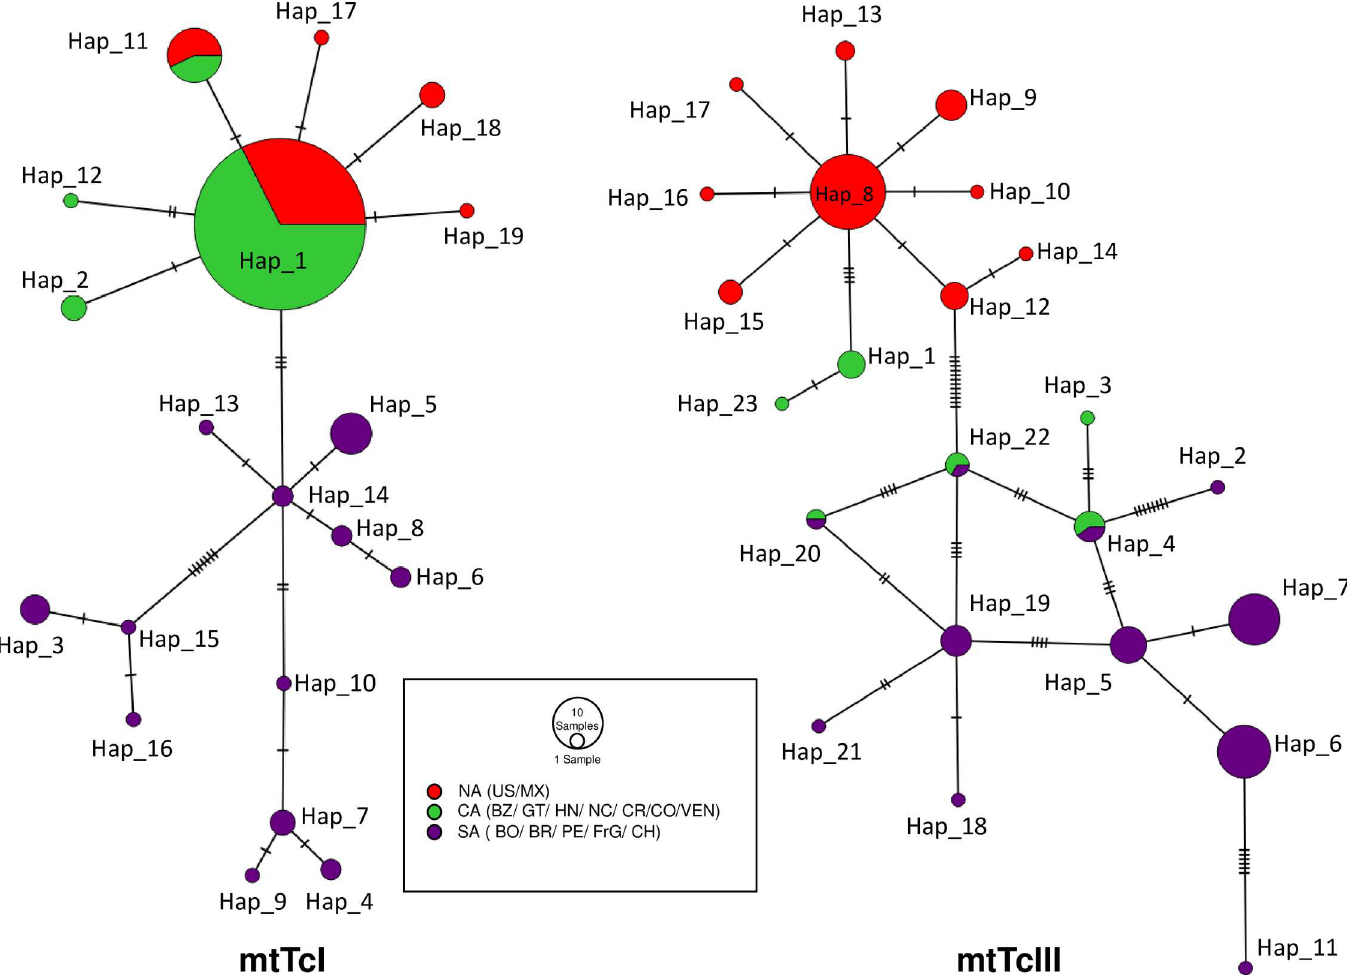
Fig 3. Minimum Spanning Haplotype Networks of mtTcI and mtTcIII lineages. Left: Haplotype Network for the mtTcI lineage. Right: Haplotype Network for the mtTcIII lineage. For both haplotypes networks, NCBI references and our samples were included (mtTcI N = 190 and mtTcIII N = 109). Circle size is proportional to the number of samples for the haplotype present. Abbreviations: US: United States, MX: Mexico, BZ: Belize, GT: Guatemala, HN: Honduras, NC: Nicaragua: CR: Costa Rica, CO: Colombia, VZ: Venezuela, BO: Bolivia, BR: Brazil, PE: Peru´, FrG: French Guiana and CH: Chile.